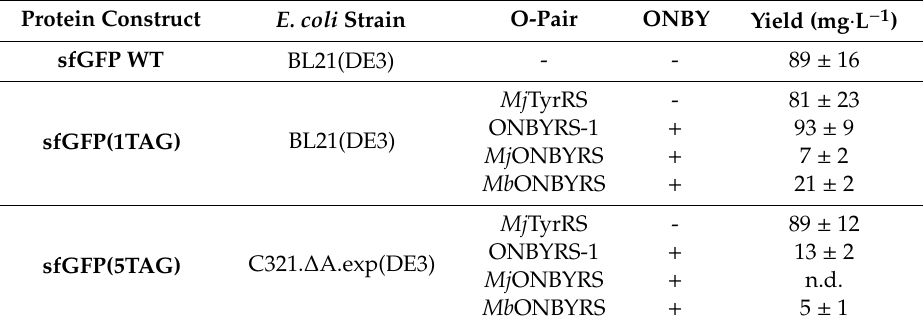
Table 2. Purified protein yields of sfGFP constructs expressed in different bacterial strains. Protein Construct